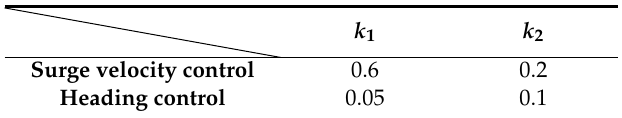
Table 4. Controller parameters.